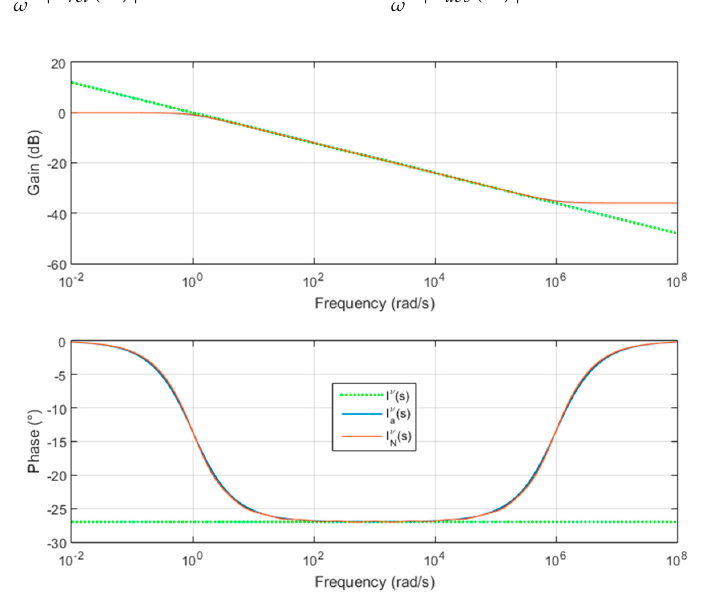
( s ) . Figure 3. Bode plot comparison of N